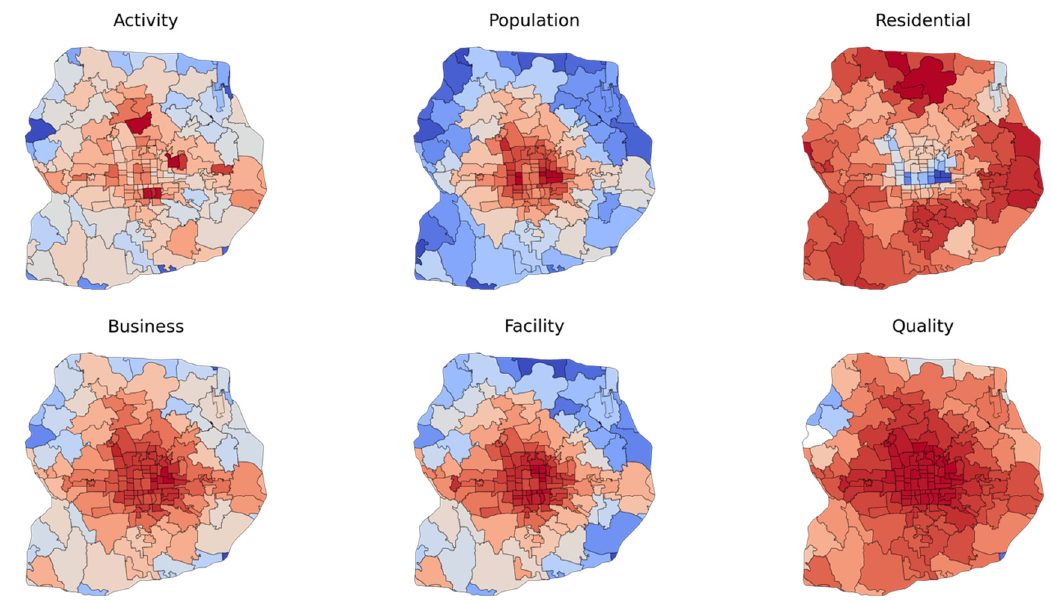
Figure 4. Aggregated physical activity and vibrancy measures at the sub-district level.